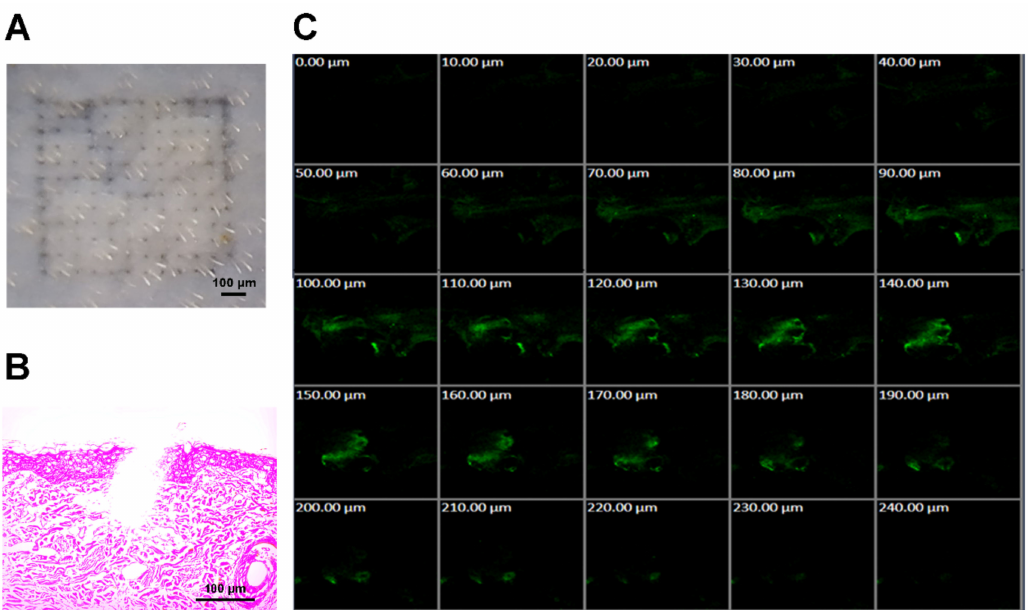
Figure 4. Skin insertion capability of the microneedles. ( A ) Digital camera image of porcine skin treated by microneedles. ( B ) H&E staining of the skin treated by the microneedles. ( C ) CLSM photos of porcine skin treated by FITC-loaded microneedles.